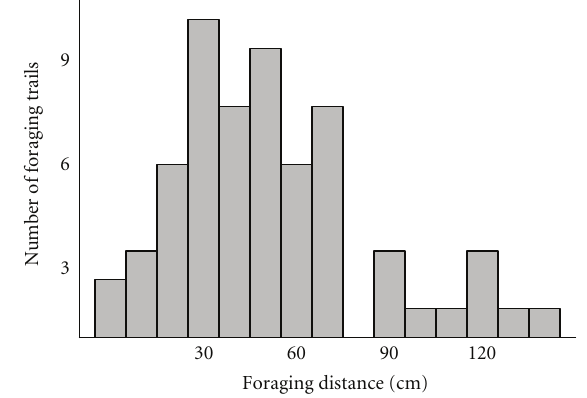
Foraging distance Figure 3: Distribution of the straight line distance, in cm, from a food item that attracted foragers to the nest entrance. Data were collected from three eastern Connecticut populations in July and August of